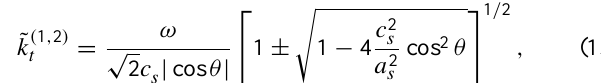
Fig. 2. The upper plot (a) presents the behaviour of k 2 z in the mag- netosphere at any values of θ and ω . The points are numbered: 1 – k t = ˜ k ( 1 ) t , 2 – k t = ˜ k ( 2 ) t , 3 – k t = | ω/c ( 3 ) s cos θ | . In a medium in motion, this plot corresponds to the sector θ ∗ ≤ θ ≤ π − θ ∗ , and the points are numbered: 1 – k t = k ( 1 ) t , 2 – k t = k ( 3 ) t , 3 – k t = ¯ k ( 1 ) t . The lower plot (b) presents the behaviour of k 2 z in a medium in mo- tion in the sector 0 ≤ θ ≤ θ ∗ . The points are numbered: 1